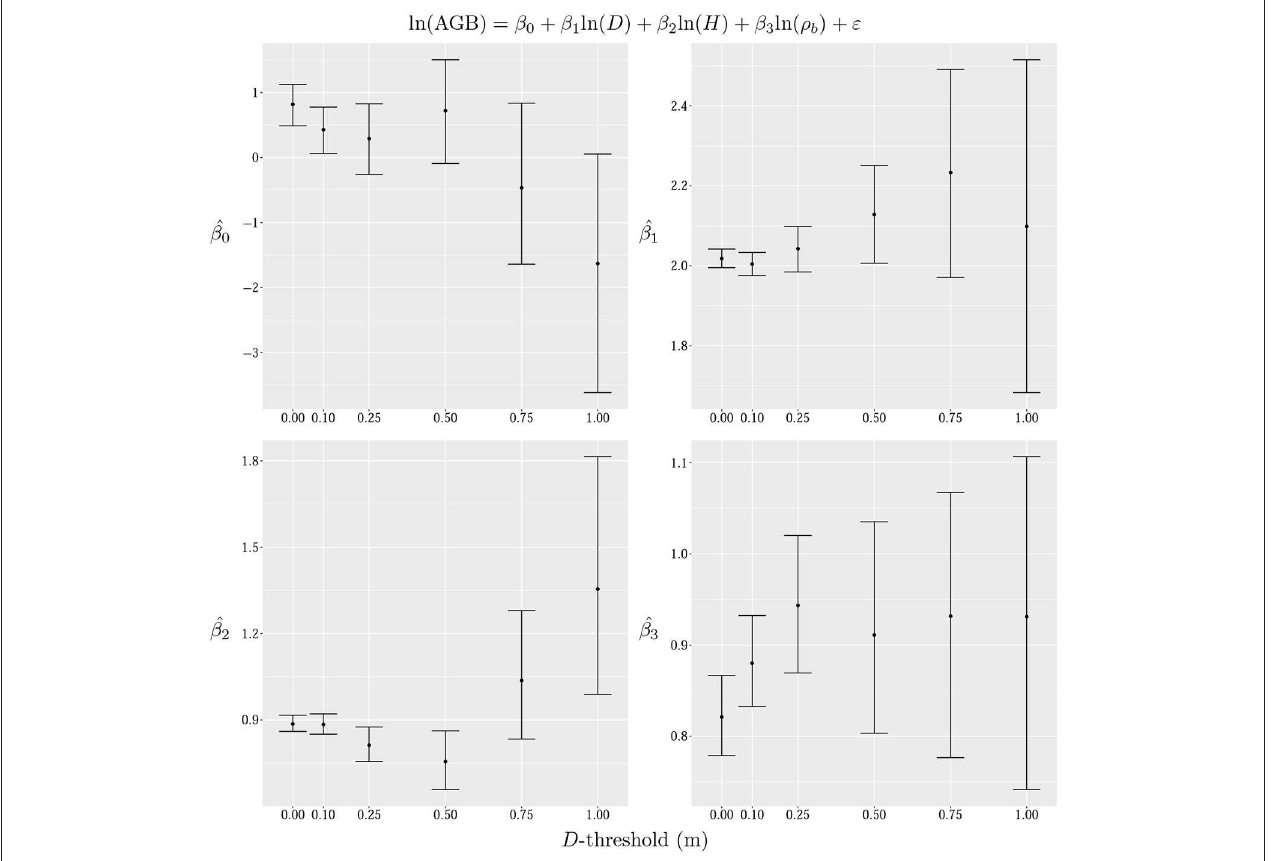
FIGURE 6 | Are pan-tropical model parameters independent of tree size? The parameters of the multivariate model, AGB = f ( D , H , ρ b ), when observations below several D -thresholds are sequentially removed. Bootstrapped BCa 95% confidence intervals ( N = 10000) are shown for each parameter. It is seen that as smaller trees are removed, the parameters associated with the predictor variables tend to increase, whilst the intercept tends to decrease. However, it is also seen that confidence intervals generally overlap one